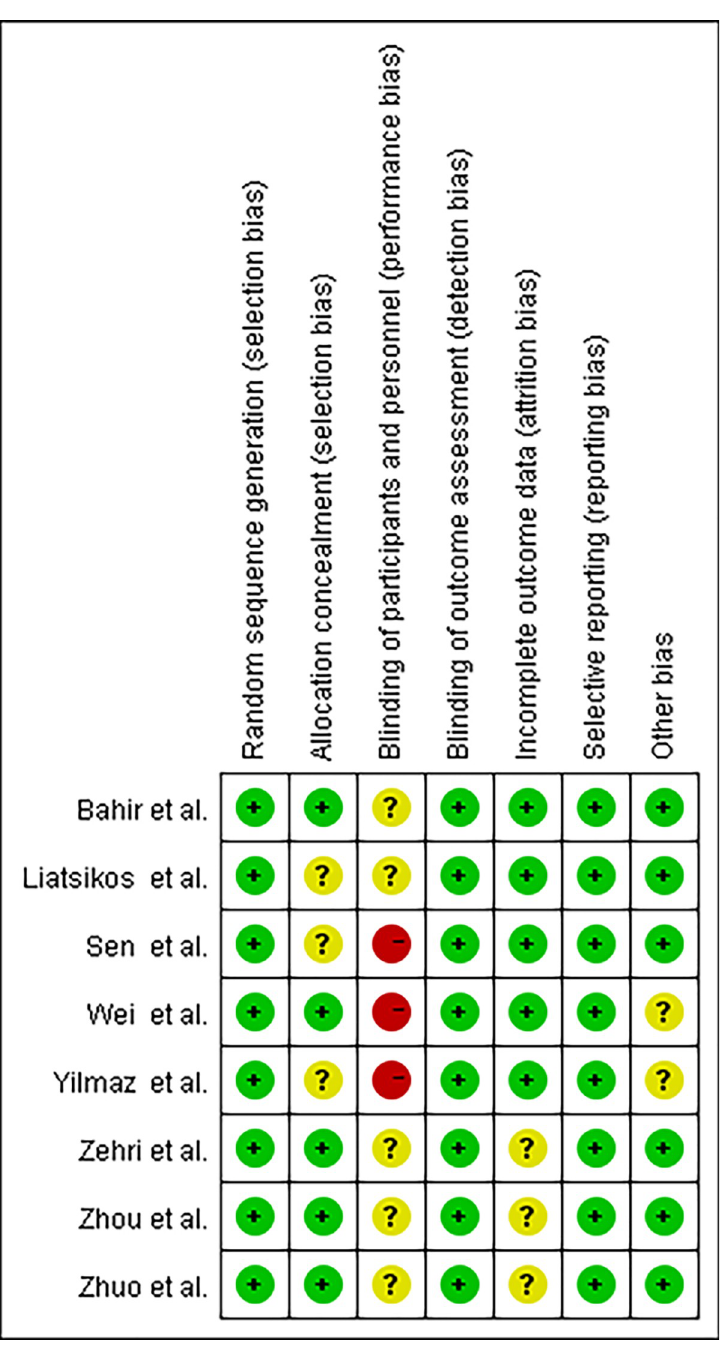
Fig 2. Quality assessment graph. (+) low risk, (?) unclear risk, ( − ) high risk. Expulsion rate. A total of three reports [9, 12, 14] on trials that included 187 participants (93 and 94 in the doxazosin and tamsulosin group) (Fig 6A) provided data for the expulsion rates. There were no statistically significant differences (OR = 0.82; 95% CI = [0.41, 1.64]; I 2 =